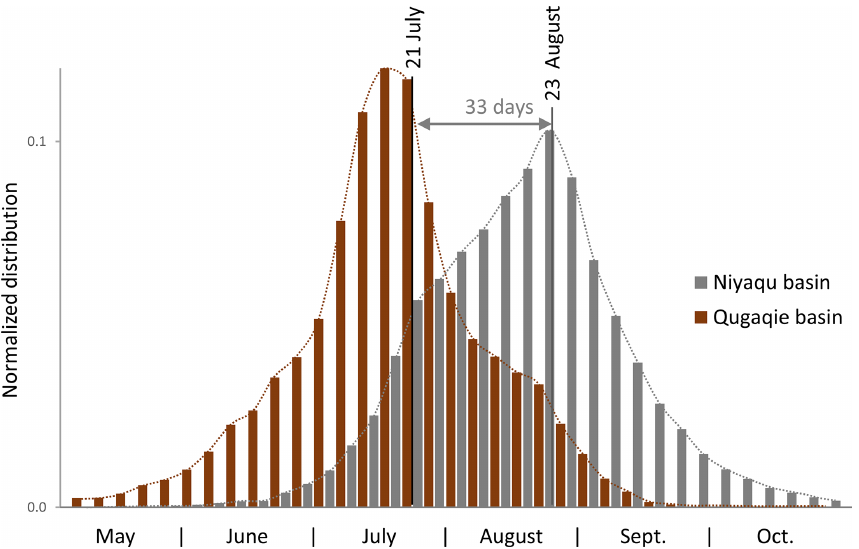
Figure 4. Normalized distribution of the thaw-induced day of maximum subsidence (DMS) in the Niyaqu basin (grey) with a median value on 24 August and the Qugaqie basin (brown) with a median value on 21 July. The lag time of 33d between the median value of the Niyaqu basin and the day of the mean maximum air temperature on 21 July (NAMORS, 2018) is also shown. The median DMS of the Qugaqie basin occurs on 19 July, resulting in no clear lag